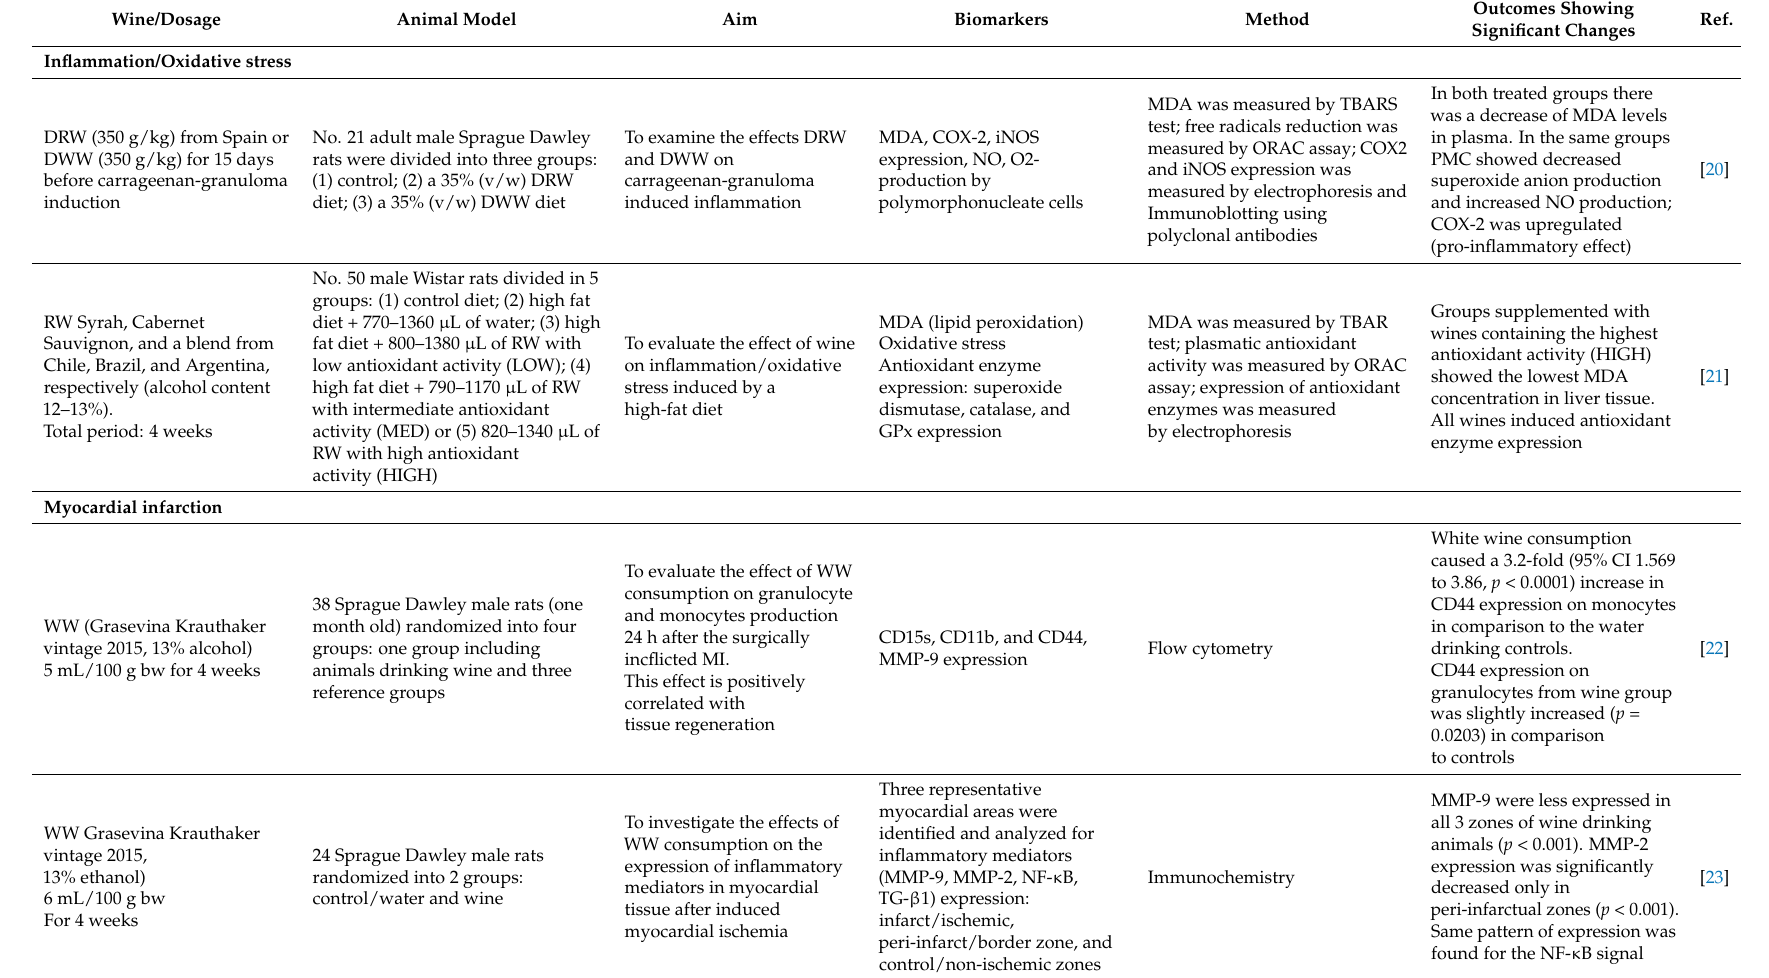
Outcomes Showing Significant Changes